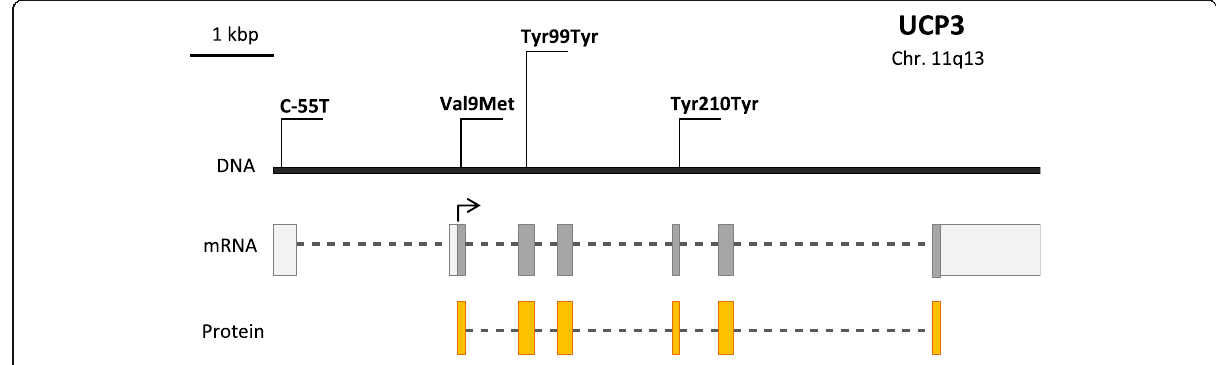
Fig. 4 Schematic structure of the Ucp3 gene and its best-studied